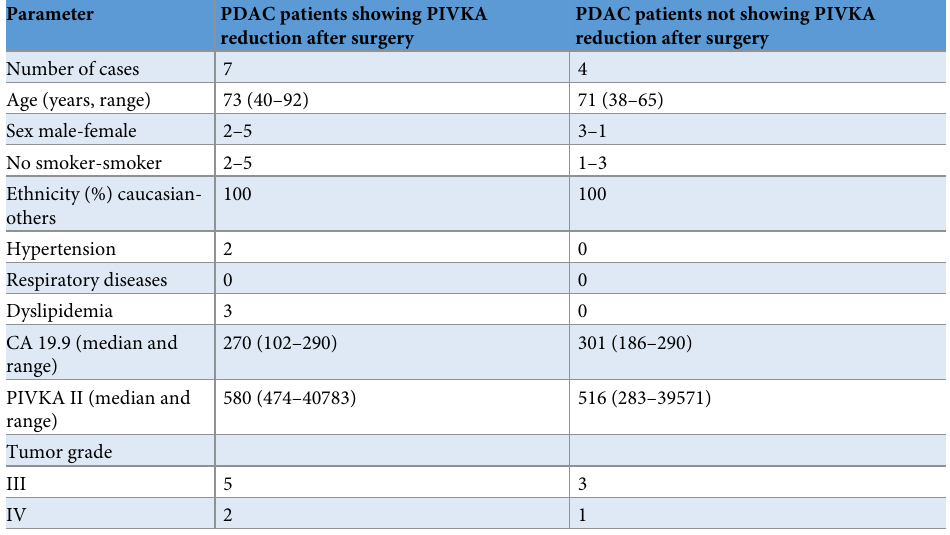
Table 2. Demographics and clinical characteristics of PDAC patients after